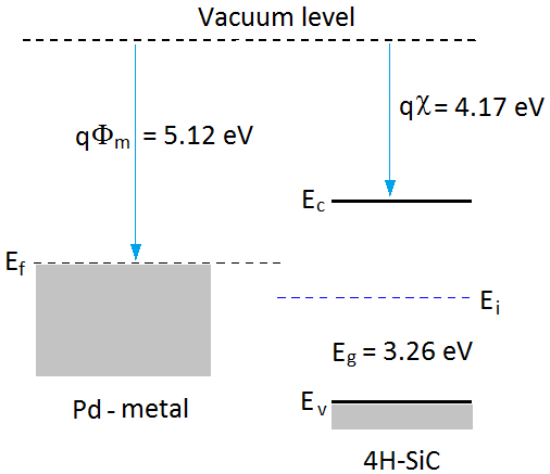
Figure 5. Energy band diagram for isolated Pd-metal and n-type SiC-semiconductor